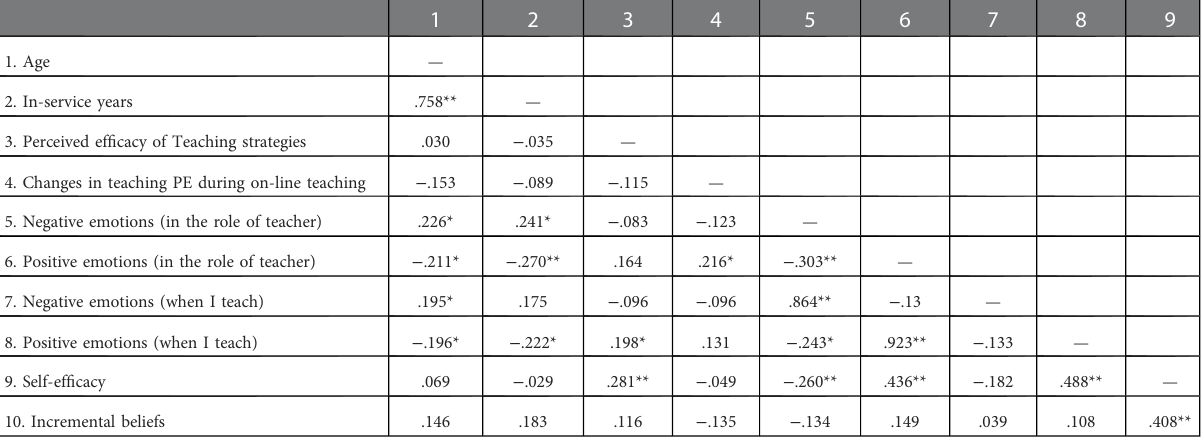
TABLE 2 Intercorrelation between all variables (overall sample n